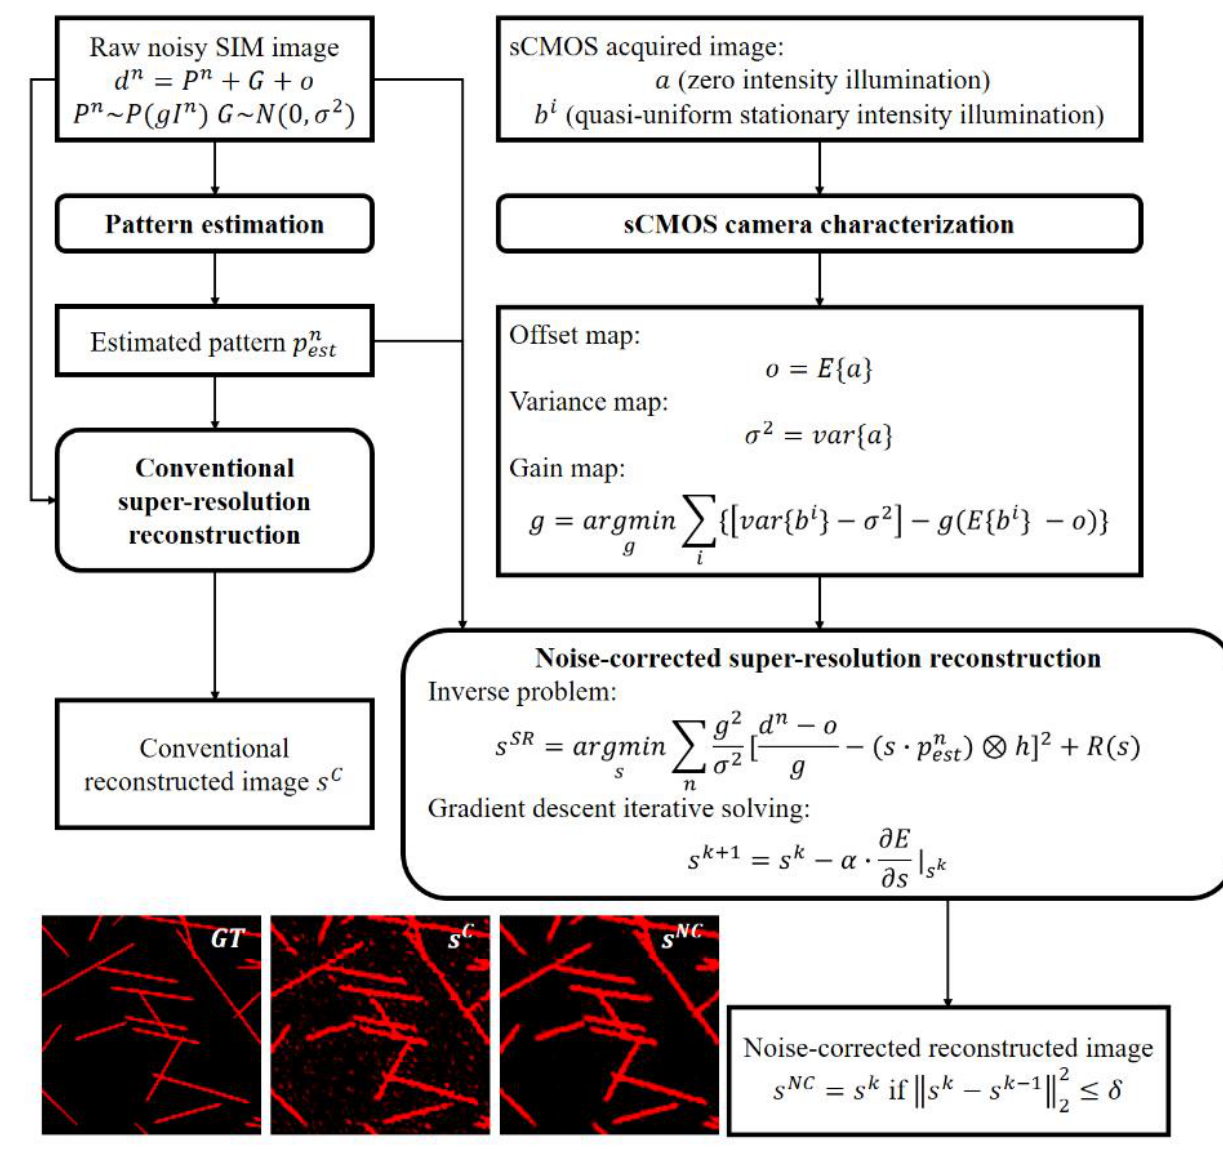
Figure 2. Diagram of the simulation pipeline.